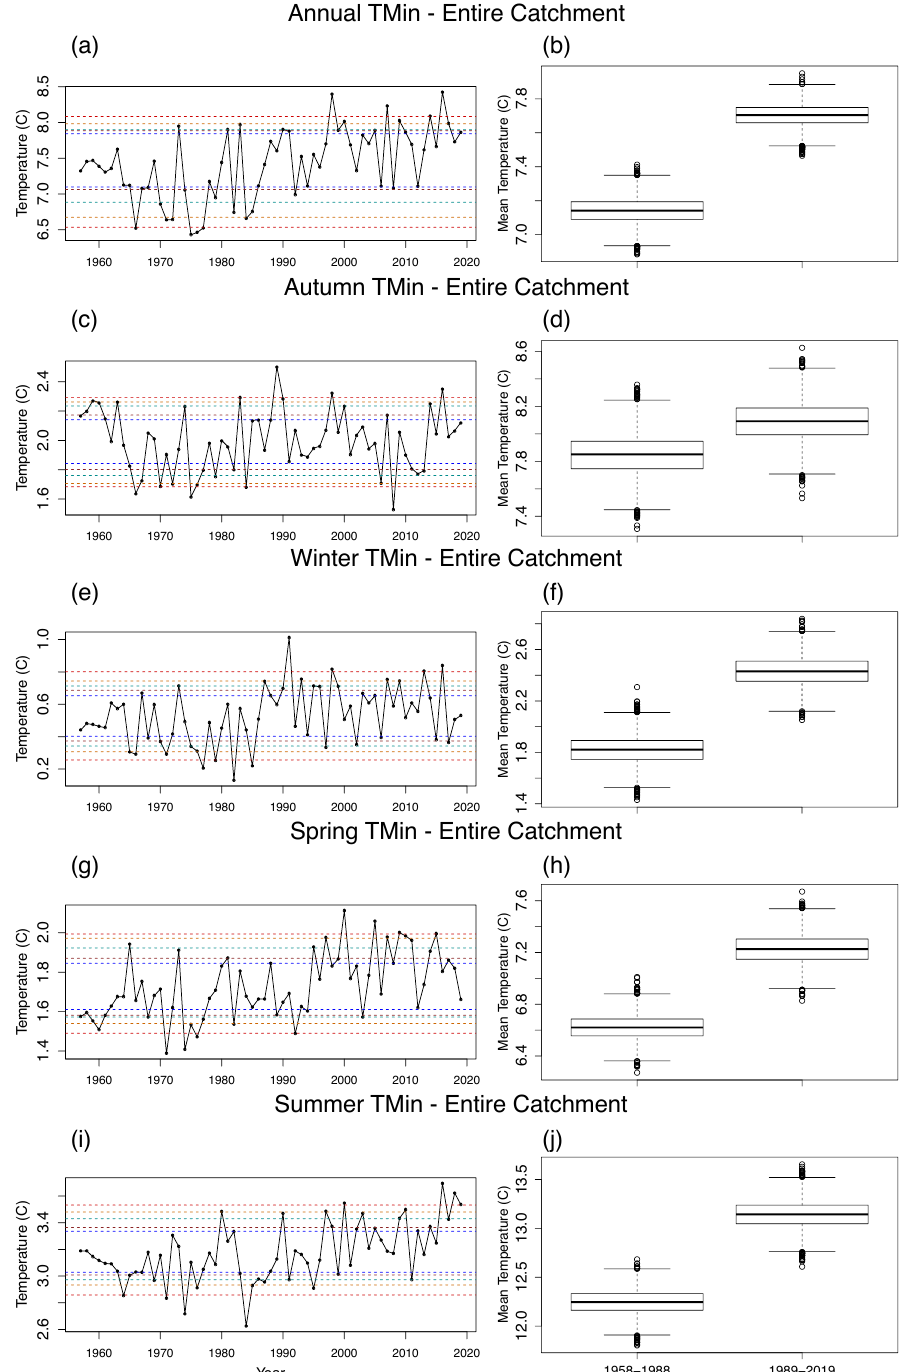
Figure 5. (left panels, ( a , c , e , g , i )) Annual mean TMin time series across the SCA; and (right panels, ( b , d , f , h , j )) box plots of the bootstrapped mean TMin over 31-year periods for the SCA, as in Figure 3 but for mean